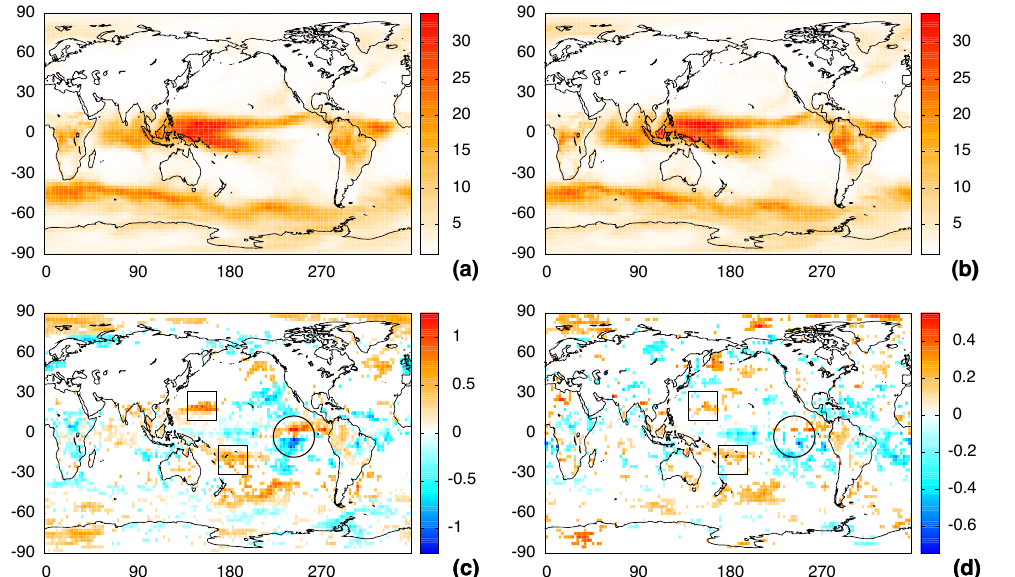
Figure 4. Relative change in the time-averaged Hilbert frequency (in units of oscillations per year). (a) Average in the first 10 years (1979–1988). (b) Average in the last 10 years (2007–2016). (c) Relative change in Hilbert frequency, (cid:49)ω/ < ω > . (d) Relative change in the number of zero crossings of the normalised SAT time series. In (a) and (b) the colour scale is adjusted to represent in white the regions where the average frequency is one oscillation per year. In (c) and (d), a good qualitative agreement of spatial structures is seen; however, we note that the Hilbert frequency detects stronger variations than those measured by the number of zero crossings.